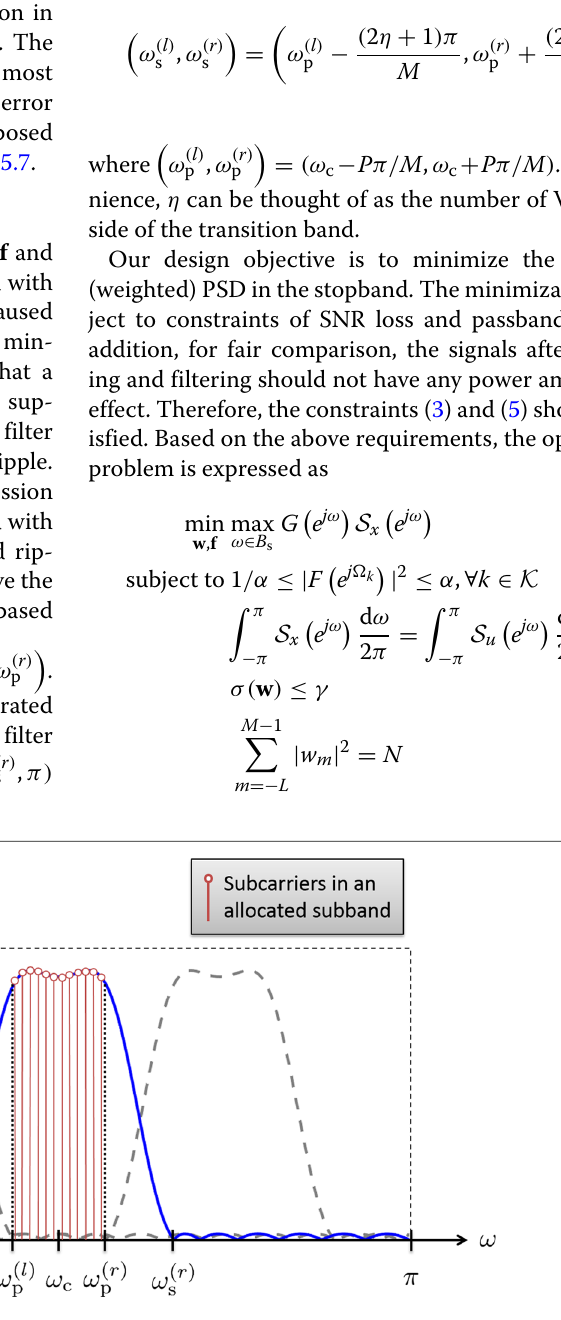
Fig. 3 An illustration of problem